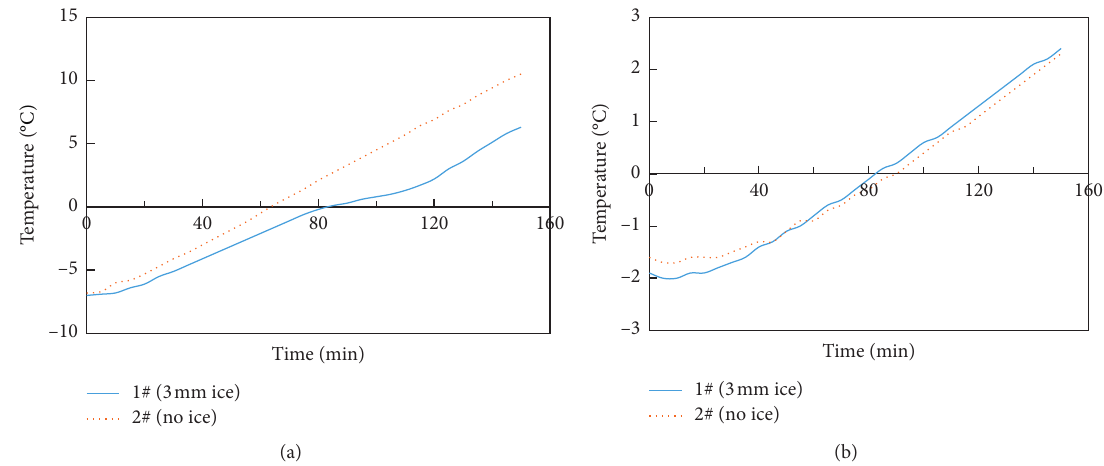
Figure 6: The asphalt pavement temperature variation with heating time. (a) 0.5cm depth. (b) 15cm depth.